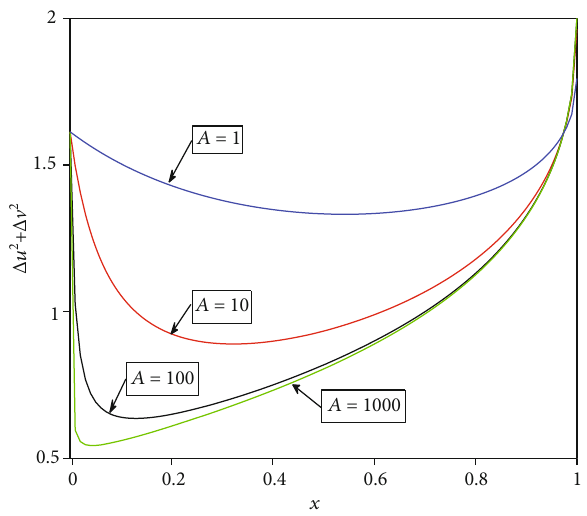
Figure 5: Duan et al. criterion Δ u 2 + Δ v 2 versus x for κ = 0 : 5 , ε = 0 : 06 , and di ff erent values of A .